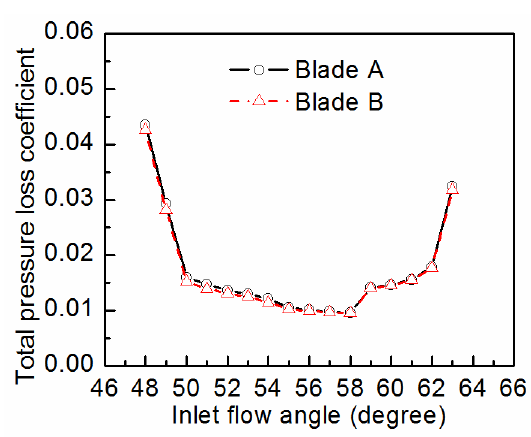
Figure 20. Loss buckets of Blade A and B.